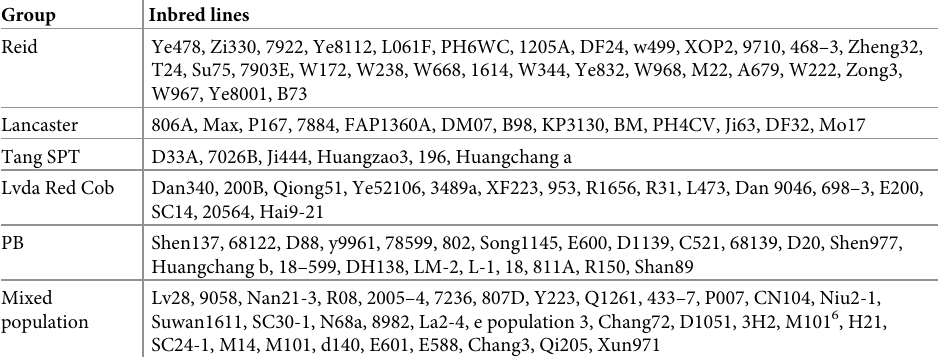
Table 4. Population division of 120 inbred